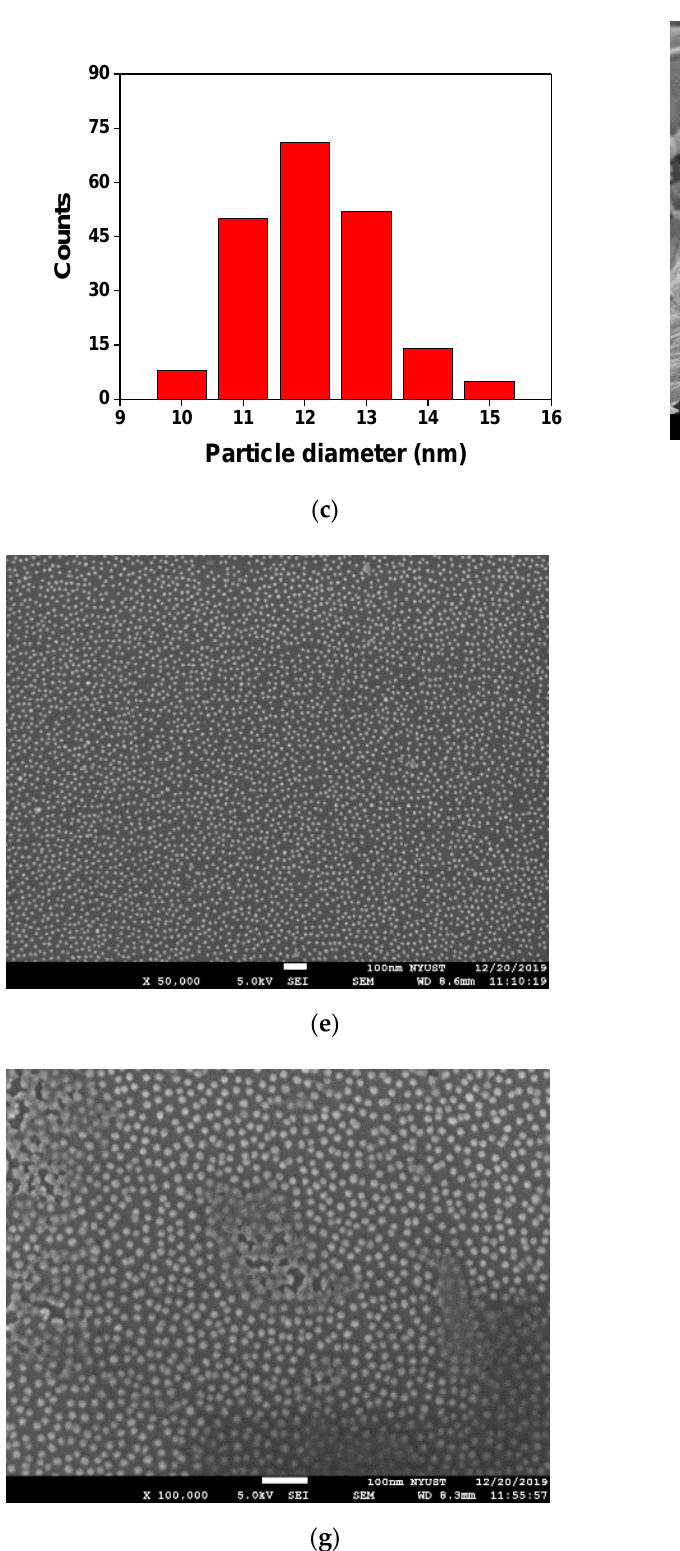
Figure 3. Structural characterizations of materials. ( a ) Absorption spectra of Au nanoparticles (AuNPs) in aqueous medium in the visible region; ( b ) TEM image of AuNPs; ( c ) size distribution of AuNPs by TEM image analysis; ( d ) SEM image of graphene oxide (GO); ( e ) SEM image of AuNPs on the fiber core surface; ( f ) size distribution of AuNPs by SEM image analysis; ( g ) SEM image of AuNPs/GO on the fiber core surface.